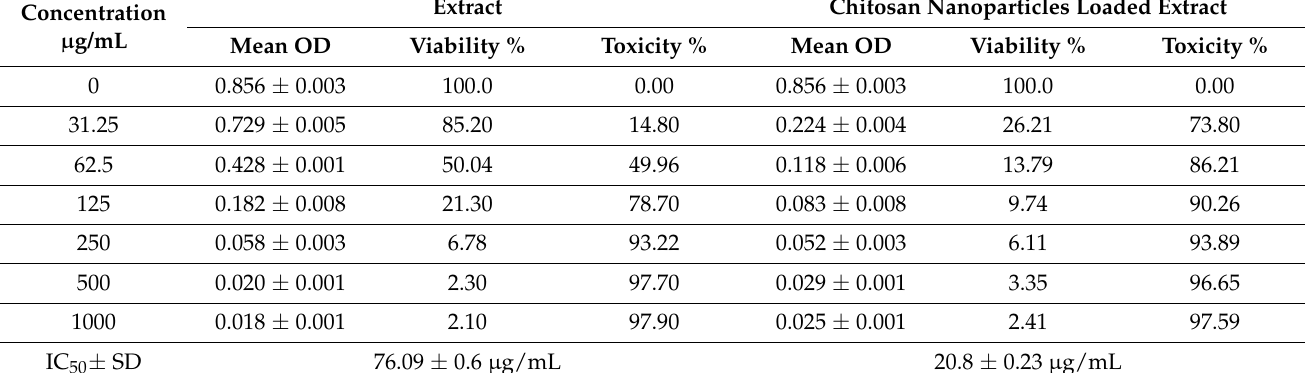
Table 4. Cytotoxicity of different concentrations of Artemisia judaica extract and chitosan nanoparticles loaded extract (CNPsLE) against the PC3 cell